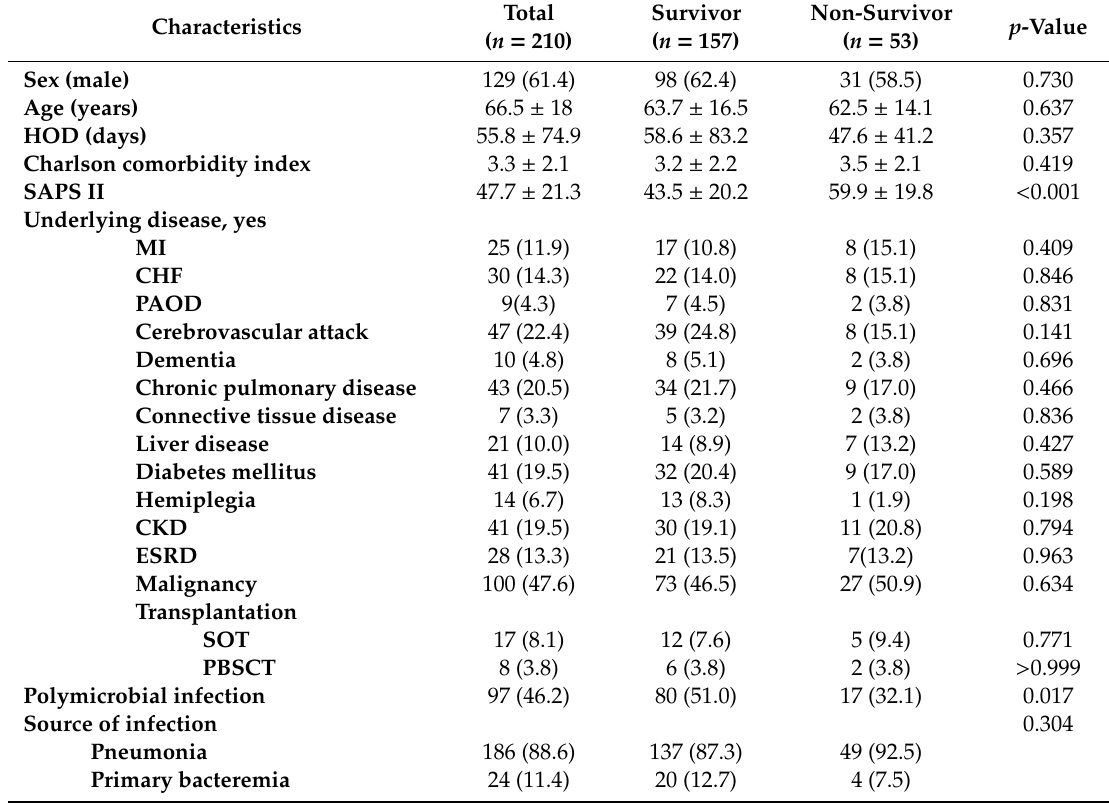
Table 1. Baseline characteristics of 210 patients with Elizabethkingia spp . infection.